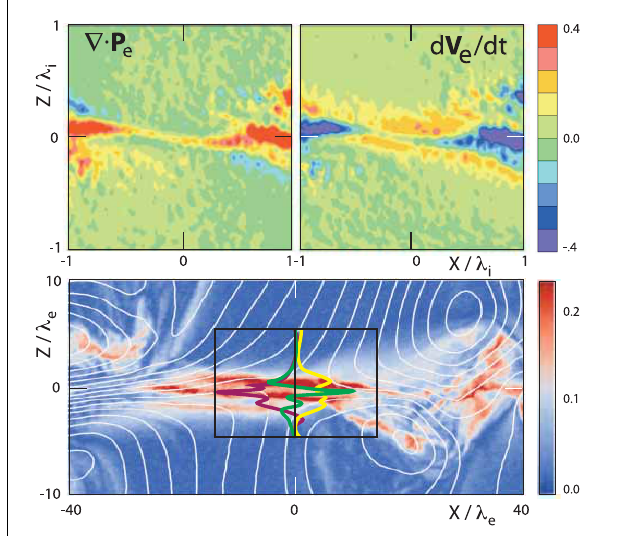
FIGURE 10 | Structure of the electron diffusion region. Top: Contributions of the electron pressure tensor ( left ) and inertial terms ( right ) to the generation of the reconnection electric field and dissipation centered in the X point frame (after Pritchett [57] courtesy American Geophysical Union). The pressure tensor elements contribute mostly away from the X point near the plasmoids. Note the spiral form of the region. The non-linear inertial term contributes near the X point above and below the symmetry line (all relative units given in the colour bar). Bottom: Three-dimensional simulation (data from Liu et al. [116]) showing the complicated spatial distribution of the electron current (from white to red; relative units in color bar) splitting into three distinct layers and twisted layers. Overlaid (transparent black box) are vertical profiles through the center (along the vertical black line) of the parallel electric field E (cid:13) ( yellow ) and its contributions (non-linear inertial term green and divergence of pressure tensor dark red ), all in relative units with amplitudes in the interval [ − 5,5%]. White lines are three-dimensional magnetic field contours in two-dimensional cut exhibiting the complicated flux rope structure generated in three-dimensional